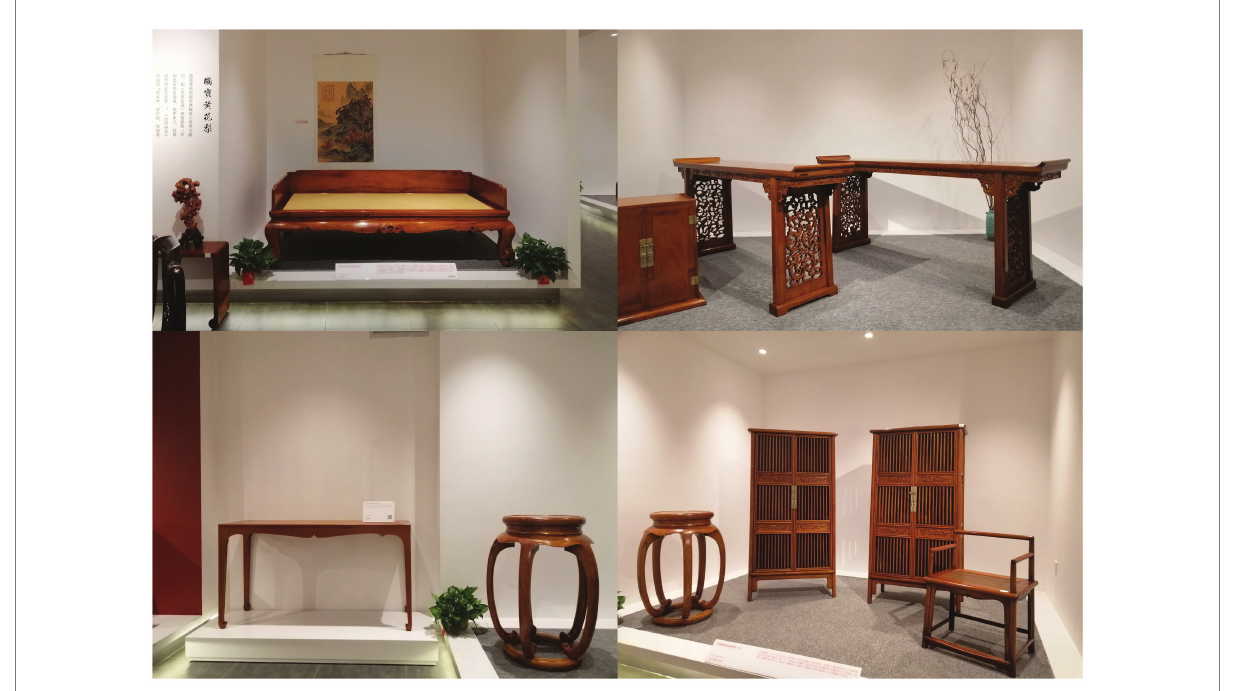
FIGURE 2 Classical furniture brand of Tanjuyuan. Those photos were provided by Jiajun Cai.